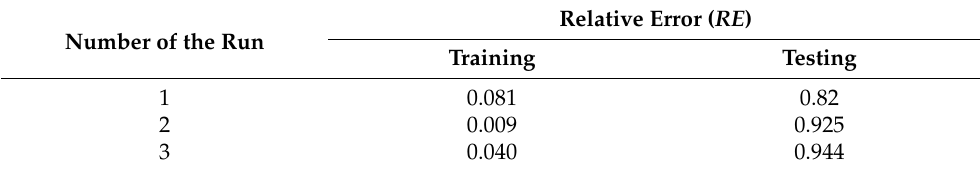
Table 5. Relative errors of the ANN model for the three runs. Number of the Run